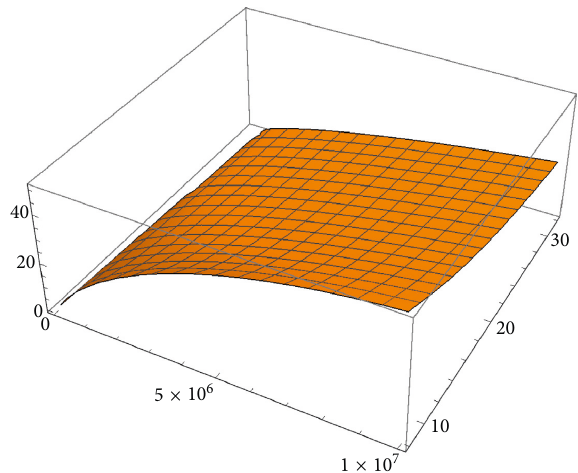
Figure 4: The relationship between energy consumption and the level of